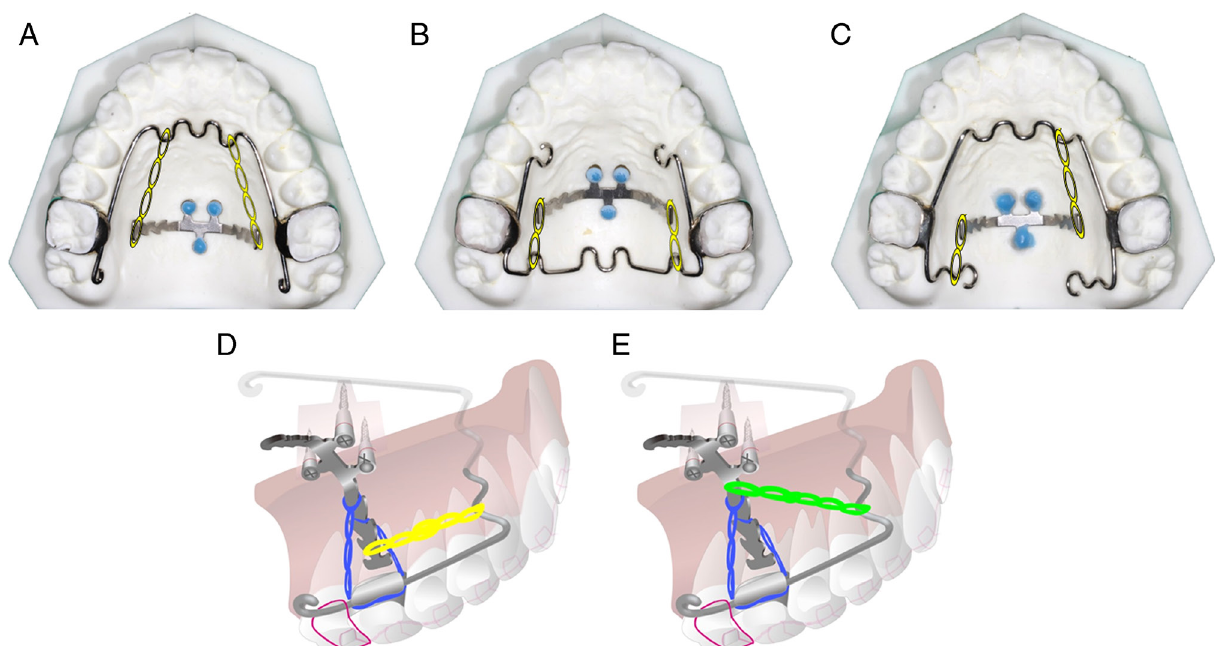
Figure 9. 3-dimensional key plate (3DKP) and various types of transpalatal WAVE wire with extension arms. (A) Molar distalisation using the WAVE wire. (B) Molar mesialisation using the transpalatal WAVE wire (T-WAVE). (C) Asymmetric molar movement with modified WAVE wire (M-WAVE). Schematic di- agram of two different lines of action for total distalisation of the maxillary dentition using the three-dimensional key plate (3DKP): (D) For bodily movement (yellow elastomers); (E) For intrusive movement (green elastomers).